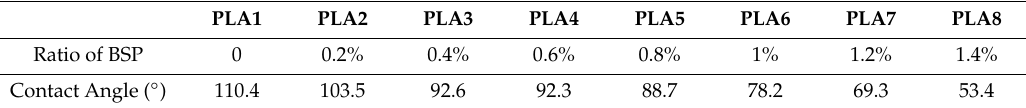
Table 6. Contact angle